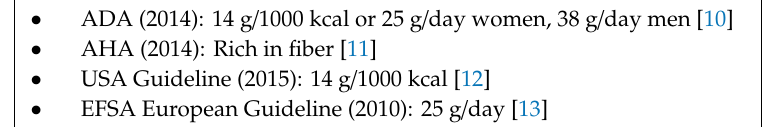
Table 1. Guidelines recommendations on fiber intake in the general population. No specific recommendation is provided for CKD (chronic kidney disease) patients by the available nephrology